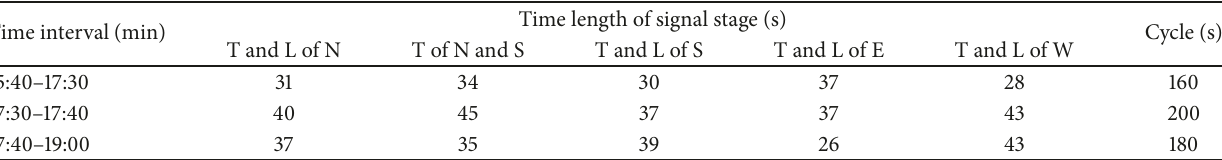
Figure 7: Proportions of traffic volume (observed and predicted). Table 1: The signal timing of the South Qilin Road-Wenchang Street intersection (downstream intersection). Time interval